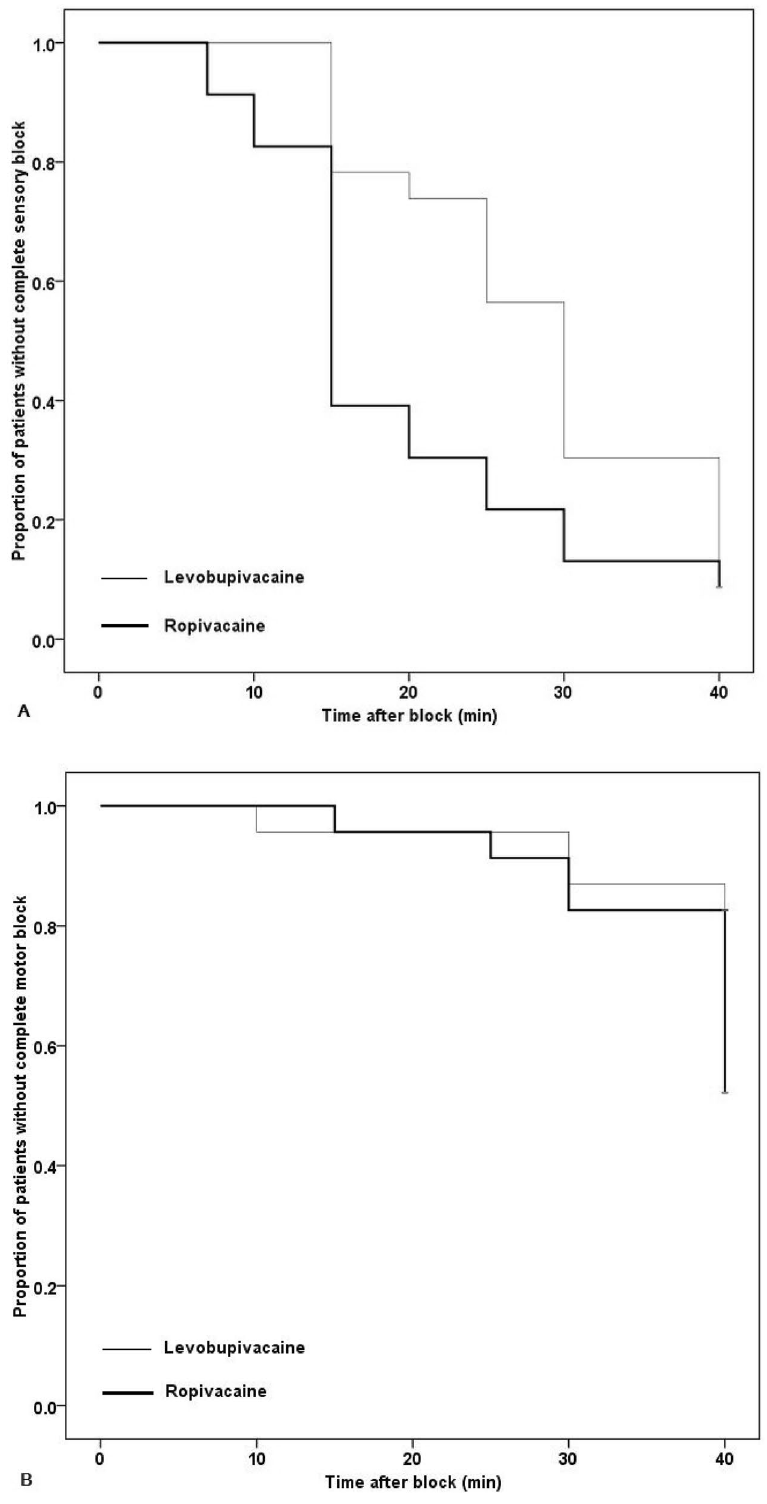
Figure 2. Kaplan–Meier curve of proportion of patients who achieved ( A ) a complete sensory block and ( B ) a complete motor block after infraclavicular brachial plexus block. ( A ) log-rank test, p = 0.032; ( B ) log-rank test, p =